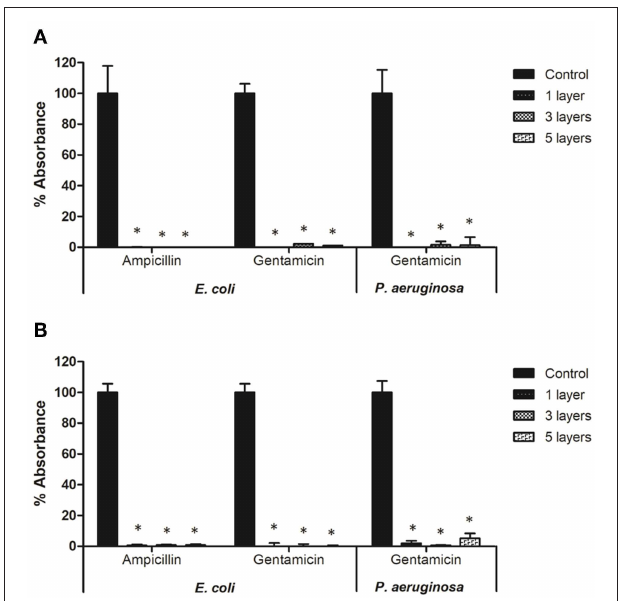
FIGURE 5 | Biofilm formation of E. coli and P. aeruginosa on microtiter plates coated with antibiotics: (A) total biomass and (B) cell viability. * indicates a significant difference between the corresponding untreated control and biofilms formed on microtiter plates coated with antibiotics ( p < 0.05).